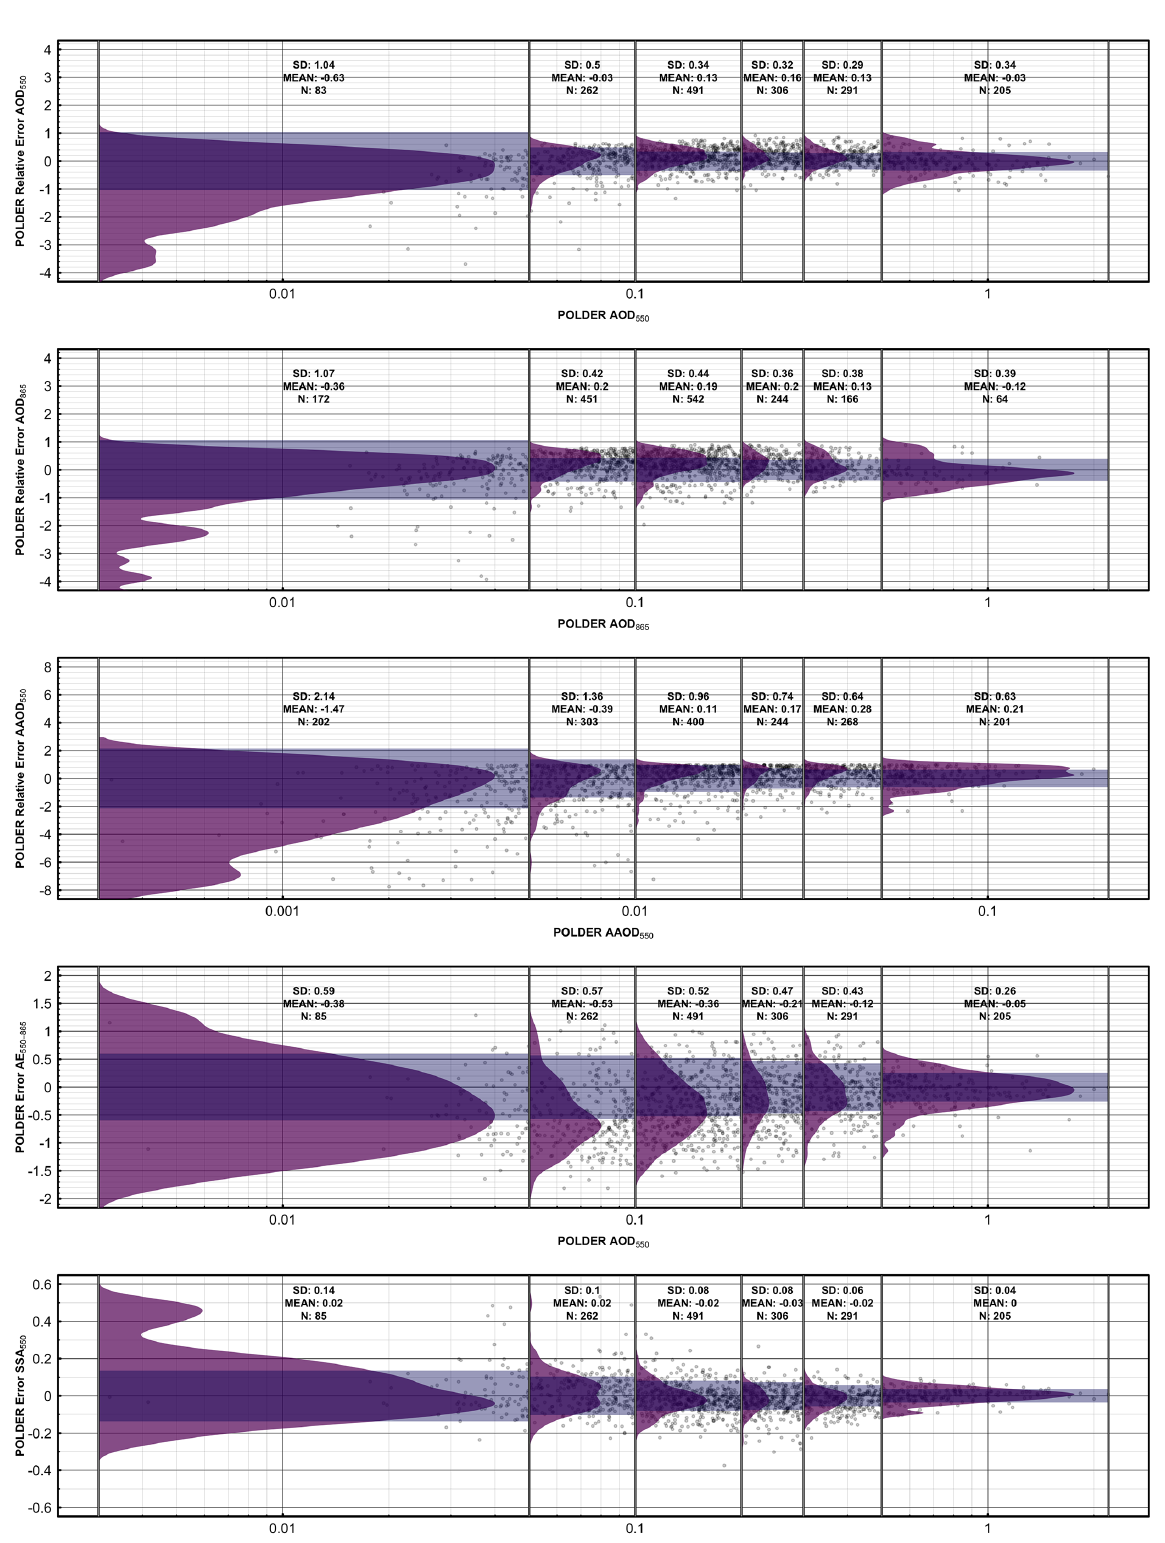
Figure A1. POLDER AOD 550 , AOD 865 and AAOD 550 uncertainty estimation using the relative errors of POLDER – AERONET and POLDER AE 550 − 865 and SSA 550 uncertainty estimation using the differences of POLDER – AERONET. Each variable is partitioned in six bins along the XX’ axis. The grey shade indicates the SD and the purple shade illustrates the distribution for each bin.